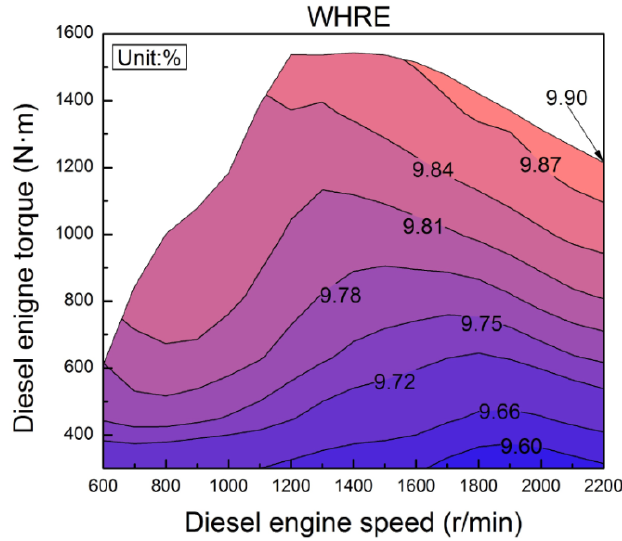
Figure 13. WHRE under engine various operating